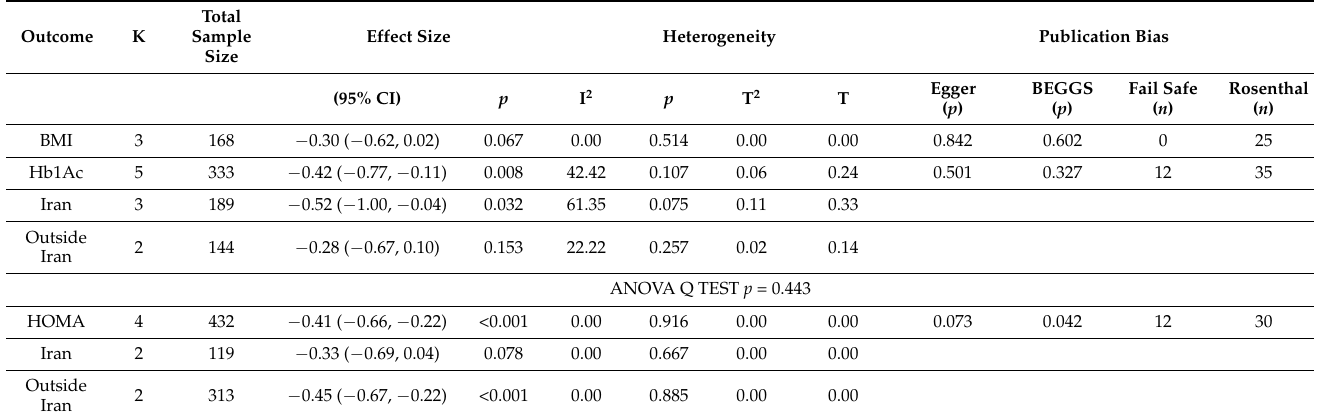
Table 2. Meta-Analysis results and moderator analysis (country: Iran versus outside